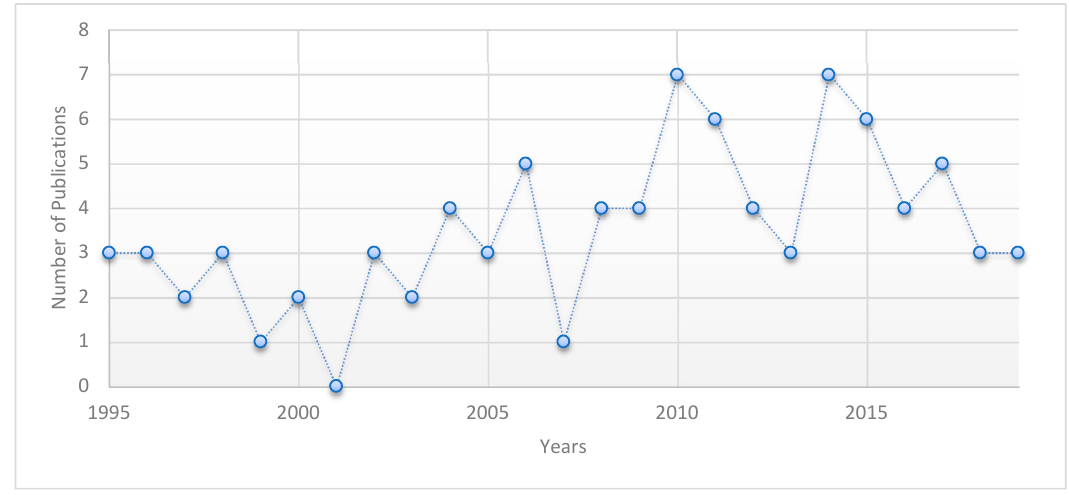
Figure 3. Number of publications per year of the 92 documents from the bibliometric analysis